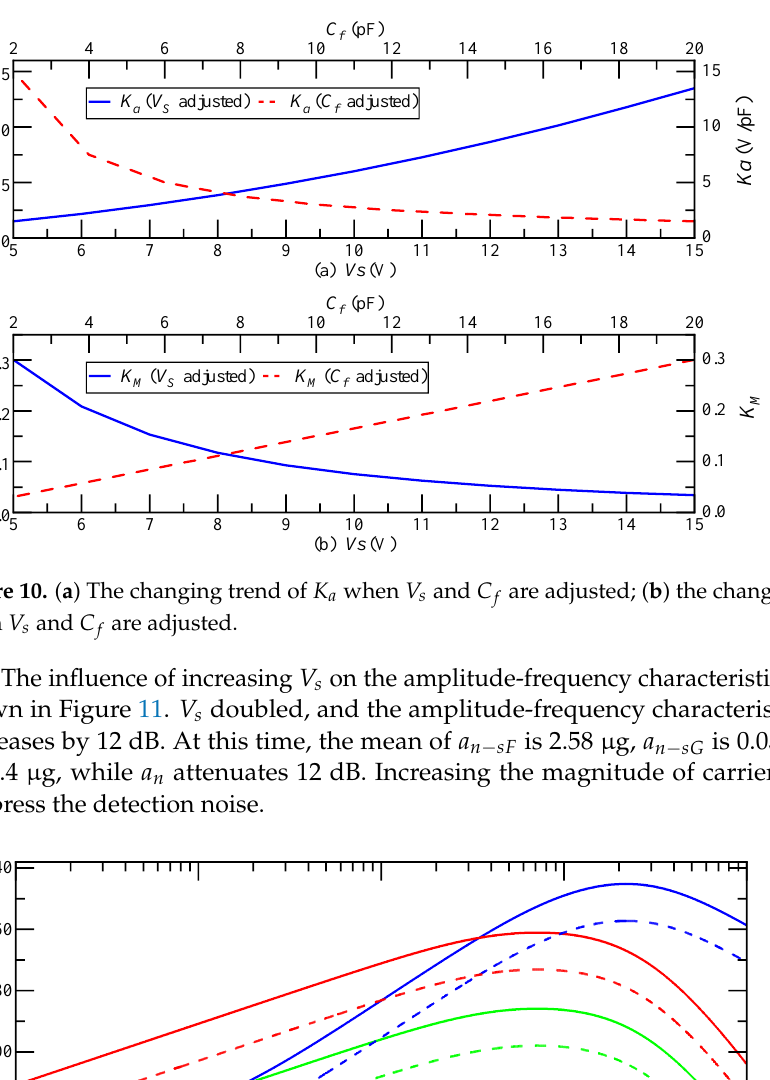
Figure 11. Amplitude-frequency characteristic curve of 𝑎 𝑛 when 𝑉 𝑠 is doubled.